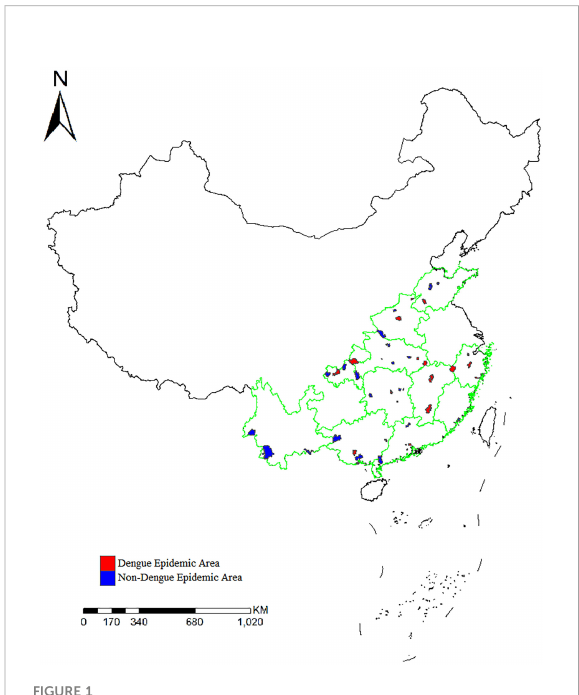
FIGURE 1 Distribution of the sample collection sites and location of dengue fever outbreak areas in 11